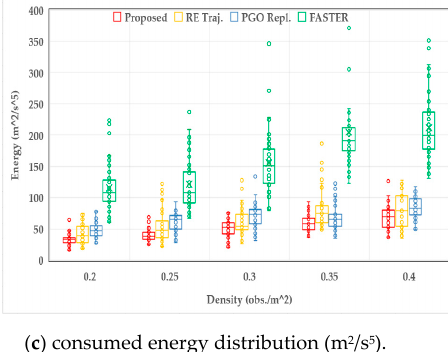
Figure 10. The distribution comparisons of the experimental results between the proposed method, FASTER, RET, and PGO in different obstacle densities.